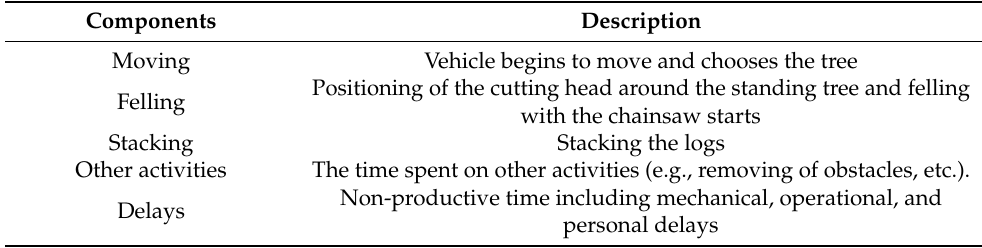
Table 1. Components of the harvesting process using a